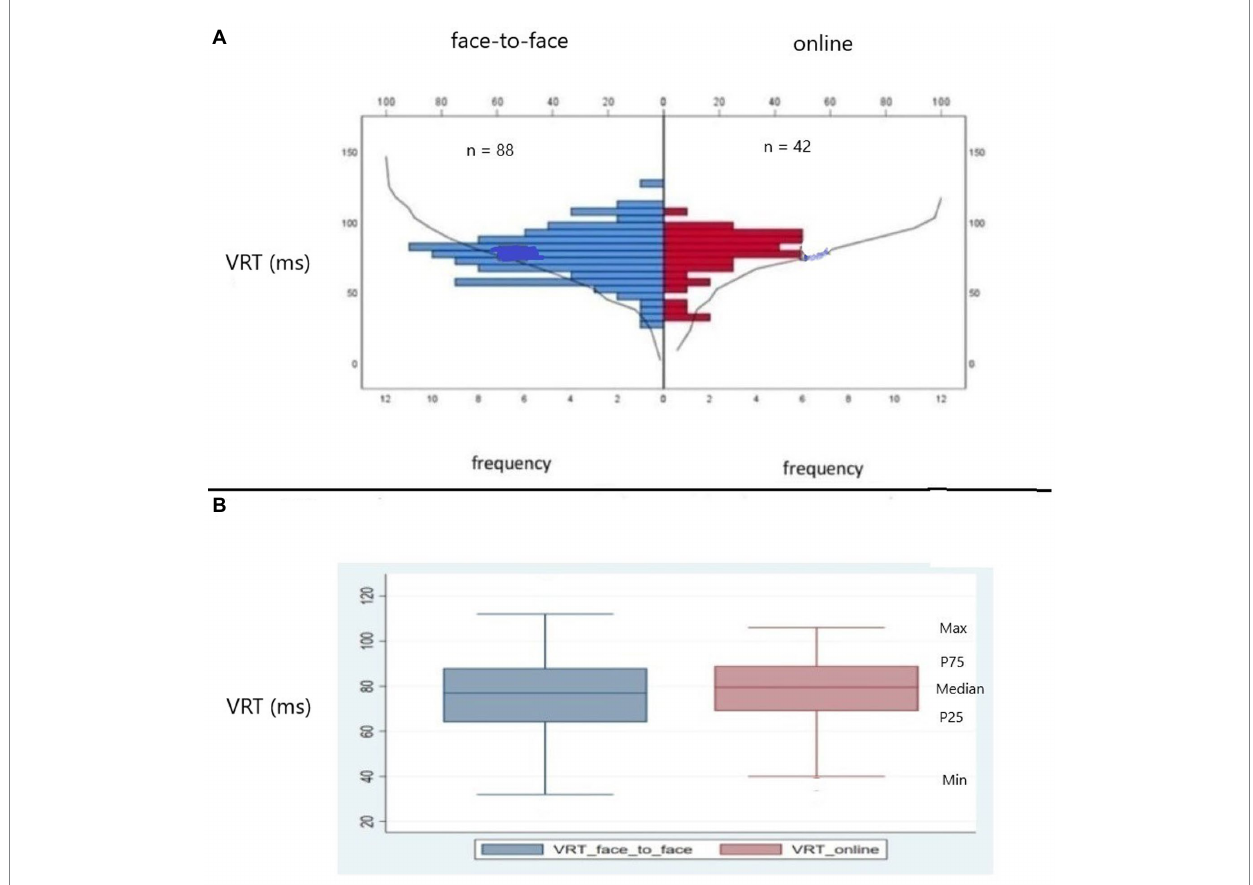
FIGURE 3 (A) Kolmogorov–Smirnov test (KS) for independent samples for variability of correct reaction time (VRT) comparing the distributions of data from American participants tested online and face-to-face. In red VRT data from participants exposed to online test; in blue, VRT data from participants exposed to face-to-face test. The frequency distributions of VRT for online and face-to-face modalities did not differ (KS = 0.59, p > 0.70, two sides, ns). ns = non-significant. (B) Box plots showing median, percentile 25th (P25), percentile 75th (P75), minimum, and maximum VRT values. In red, VRT data from participants exposed to online test. In blue, VRT data from participants exposed to face-to-face test. Observe that the frequency distributions for both modalities are similar.